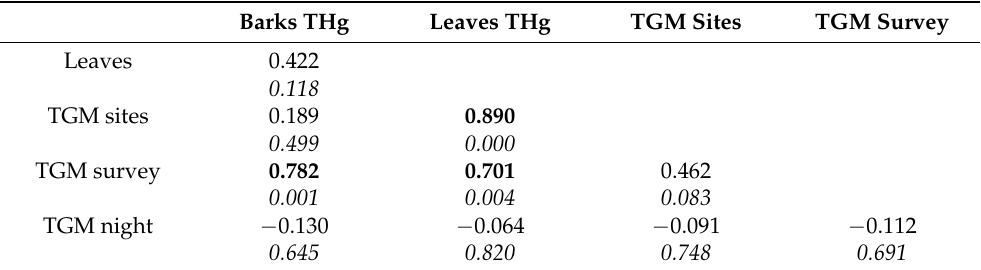
Table 2. A single Pearson correlation matrix between the main factors studied: THg in leaves and barks, and TGM concentrations in the 14 sites, in a complete survey and during the night hours. Barks THg Leaves THg TGM Sites TGM Survey Leaves 0.422 0.118 TGM sites 0.189 0.890